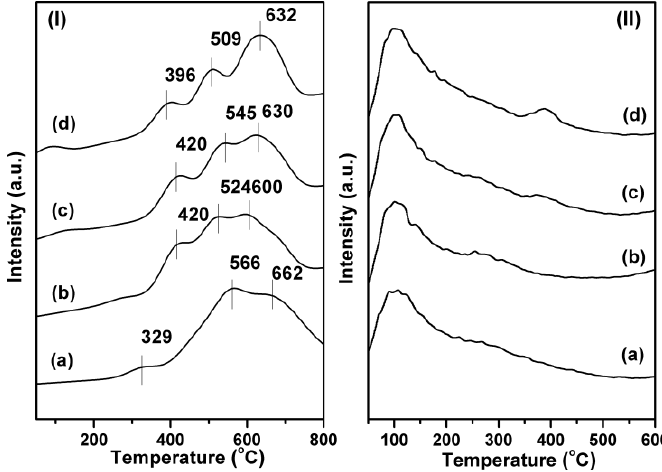
Figure 4. The H 2 -TPR ( I ) and NH 3 -TPD ( II ) of 17.5% Ni/Al 2 O 3 -500 ( a ), 17.5% Ni-1.7% P/Al 2 O 3 -500 ( b ), 17.5% Ni-2.9% P/Al 2 O 3 -500 ( c ), and 17.5% Ni-4.4% P/Al 2 O 3 -500 ( d